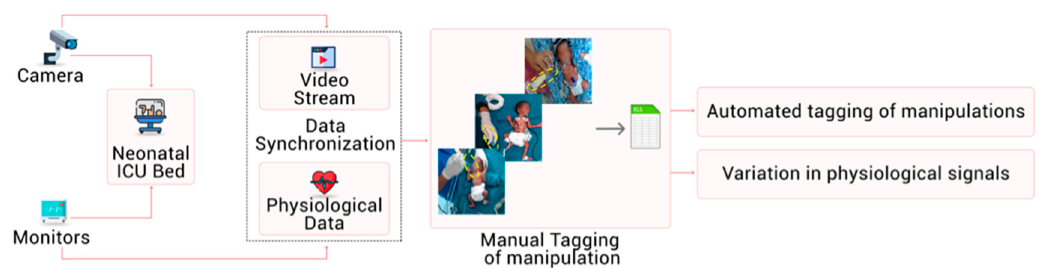
Figure 2. The overall architecture of machine learning (ML)-based video classification system in the NICU.